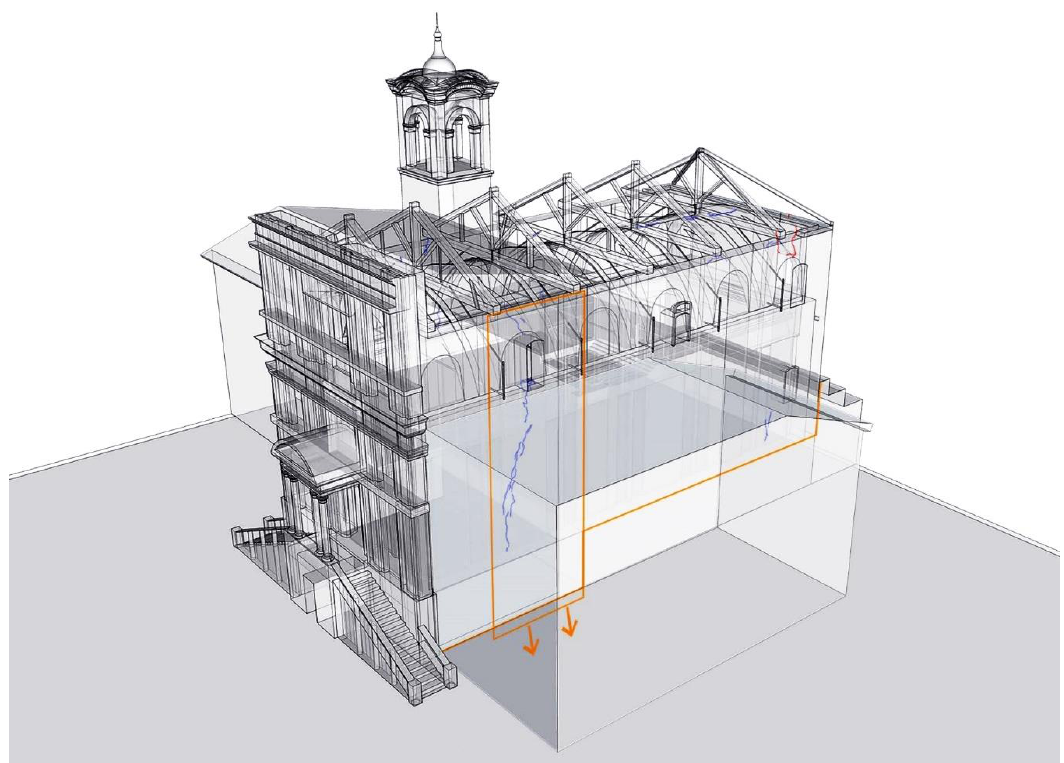
Figure 15. Visual representation of the relation between the observed damage and soil-settlements.